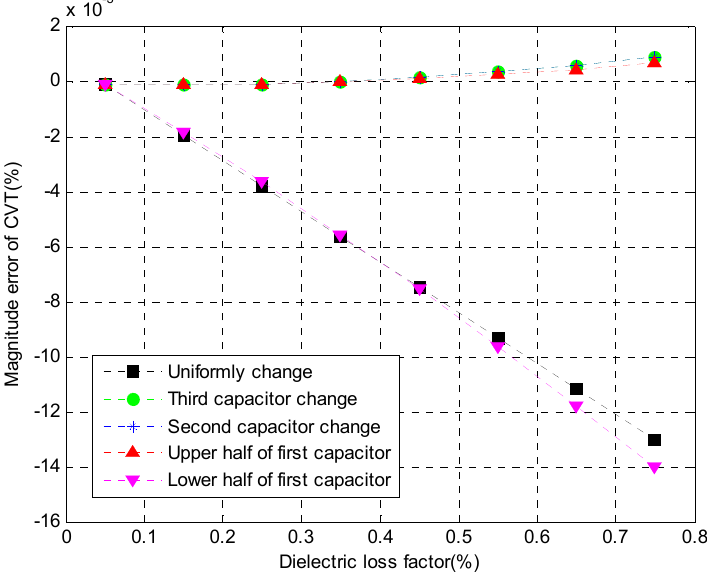
Figure 10. CVT magnitude error with different dielectric loss factor.